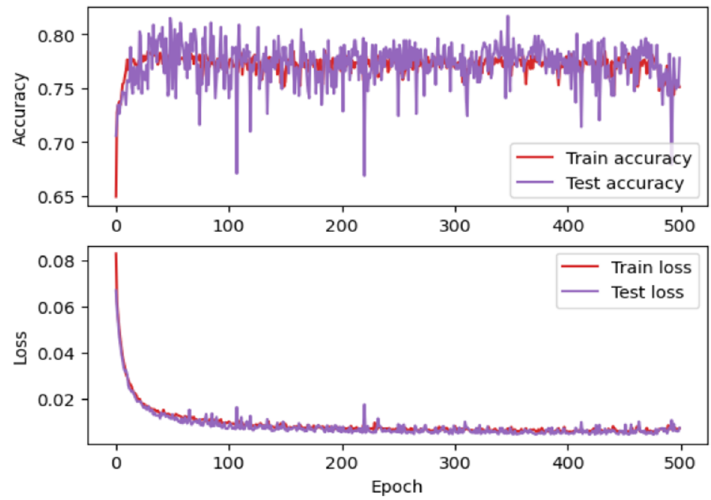
Figure 14. Accuracy corresponding to the first architecture.